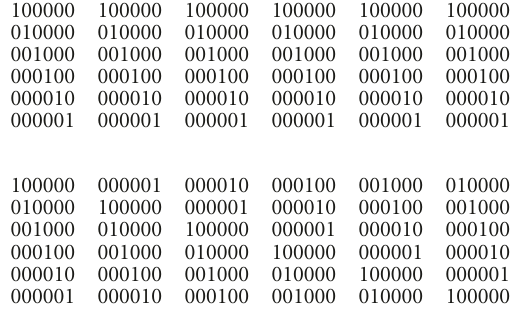
Figure 5: Matrix representation of a (6,4) cage graph.